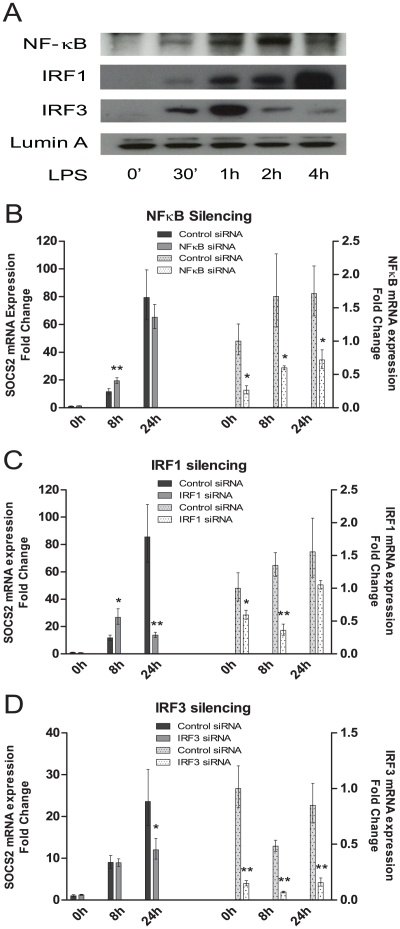
Type I IFN regulated IRFs, but not NF-κB were required for SOCS2 mRNA induction by TLR4 signaling in human moDCs.(A) NF-κB, IRF1 and IRF3 nuclear translocation in TLR4 signaling in human moDCs. moDCs were stimulated with LPS at the indicated time points. Nuclear protein was extracted for Western Blotting measurement. The levels of p65NF-κB, IRF1, IRF3 and Lamin A (as loading control) were detected. (B–D) The effect of silencing NF-κB, IRF1 and IRF3 on the induction of SOCS2 mRNA in LPS stimulated human moDCs. moDCs were transfected with (B) NF-κB, (C) IRF1, (D) IRF3 siRNAs or control siRNA and incubated for 24 hours. The transfected cells were exposed to LPS for 0 h, 8 h or 24 h, the cells were then harvested for the mRNA measurement by qRT-PCR to demonstrate the effect of SOCS2 mRNA induction (left part) and efficiency of target gene knockdown (right part). Data shown are representative of three independent experiments and are expressed as the –fold induction of the gene of interest at different time points compared to time point 0 for control siRNA where the values were set to 1. Statstical significance comparing results from the target siRNA to control siRNA group is indicated (* p<0.05; ** p<0.01).